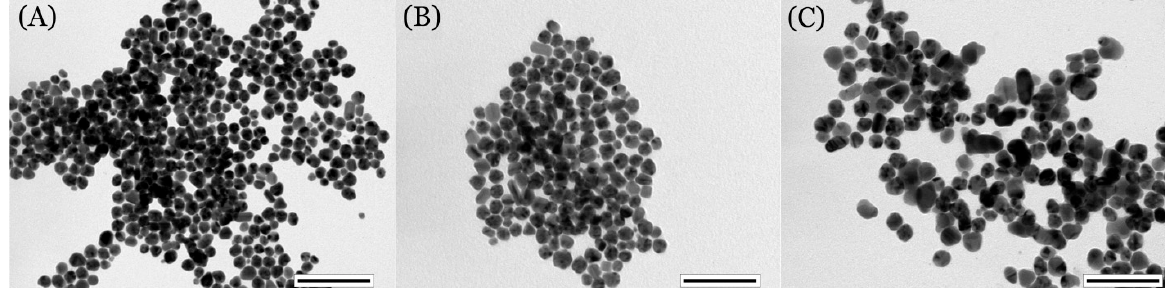
Figure 3. Images from transmission electron microscopy showing as-synthesized AgNPs ( A ) and AgNPs after laser irradiation at fluencies 14 mJ cm − 2 ( B ), 22 mJ cm − 2 ( C ). Scale bar is 100 nm.